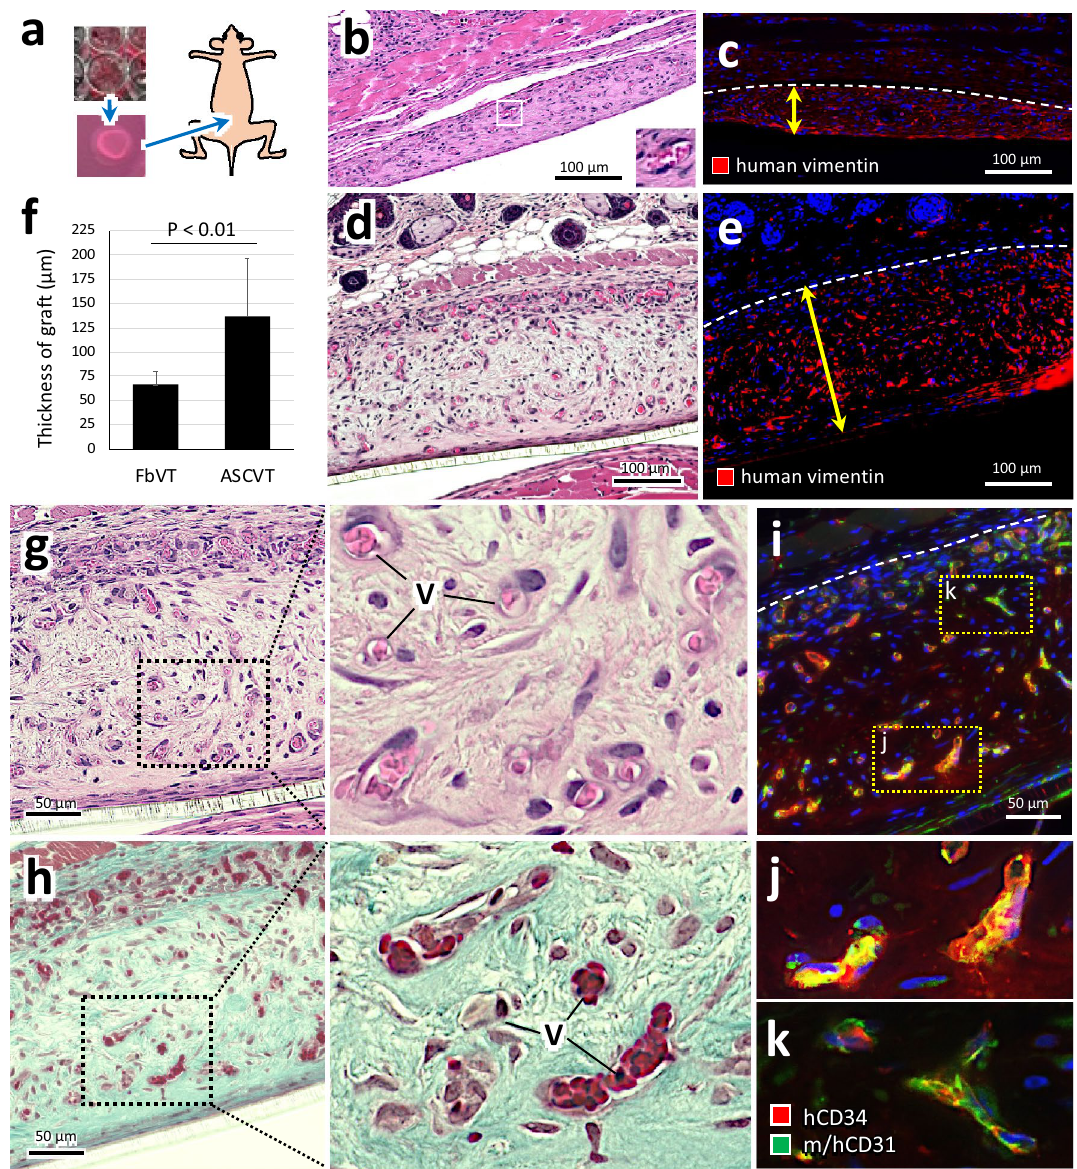
Figure 5. Subcutaneous transplantation of ASCVT to nude mice. ( a ) FbVT and ASCVT were cut out from the Transwell inserts and subcutaneously transplanted to back skin of nude mice. ( b – e ) Engrafted FbVT ( b , c ) and ASCVT ( d , e ) at 2 weeks after the transplantation. ( b , d ) HE staining; ( c , e ) immunostaining for human vimentin. The FbVT engrafts as connective tissue containing vascular networks with host blood ( b , inset). The thickness of engrafted human-derived tissue is visualized by immunoreaction of human vimentin ( c ). The ASCVT also subcutaneously engrafted with vascular networks ( d ), and the thickness was higher than engrafted FbVT ( e ). ( f ) Quantitative comparison of the graft thickness between FbVT and ASCVT (N = 7). The ASCVT significantly shows higher thickness. ( g – k ) High magnified images of engrafted ASCVT. ( g ) HE staining. The graft contains the capillary- or small venule-like structures with host blood (V) and abundant stroma. ( h ) MassonGoldner staining for serial section of ( g ). The stroma stained for collagen fibers, indicating the construction of connective tissue. ( i – k ) Immunostaining by using antibodies for human CD34 (red) and mouse/human CD31 (green). The engrafted vessels derived from HUVECs are positive for both antibodies ( i , j ). At the peripheral area of the graft, the vessels with staining by antibodies for mouse/human CD31 and partial staining by antibodies for human CD34 are observed ( i , k ) suggesting the anastomotic region between host and graft circulation. The nuclei of the cells in the dark field images were visualized by DAPI (blue color). The images are representatives from three independent